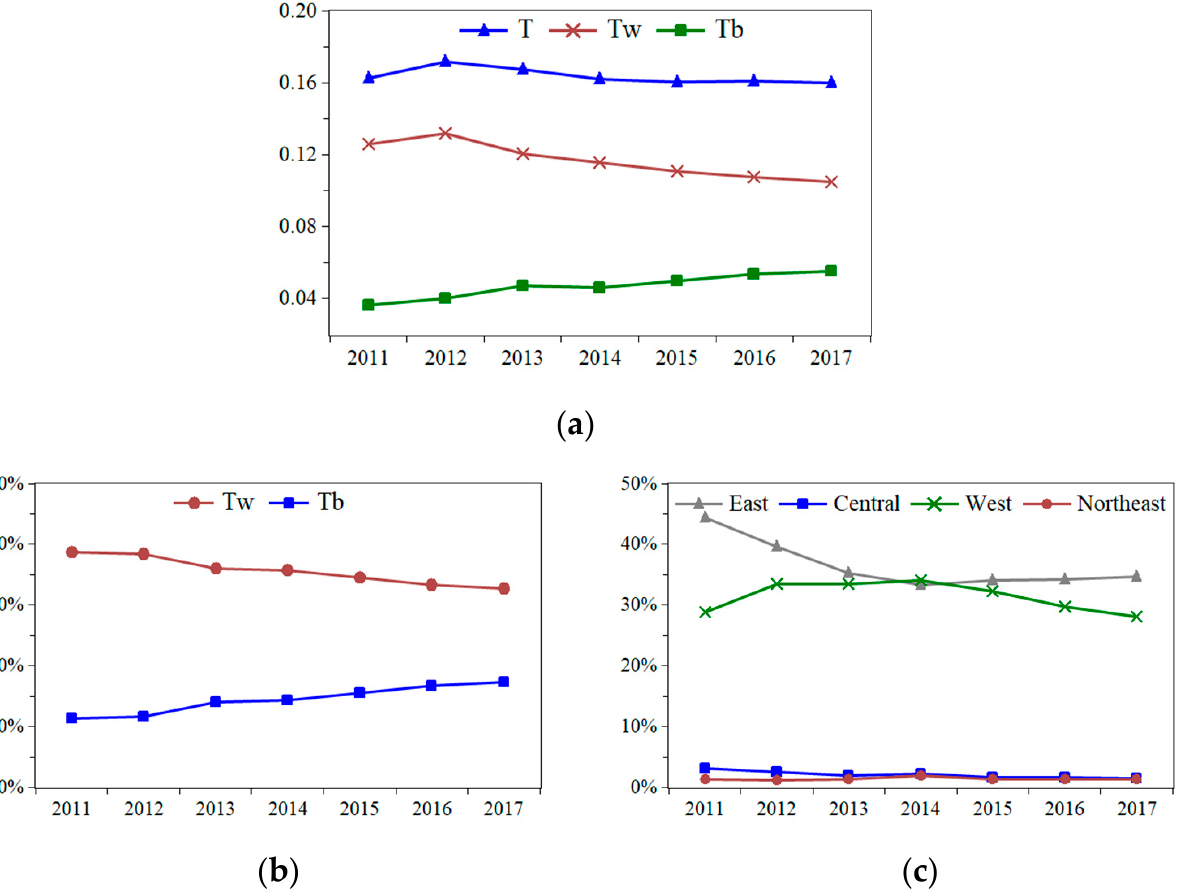
Figure 4. Spatial differences and contribution rates in SLUE in China. ( a ) Variation trend in the Theil index in China; ( b ) Contribution rates of T w and T b ; ( c ) Contribution rates of regional differences.